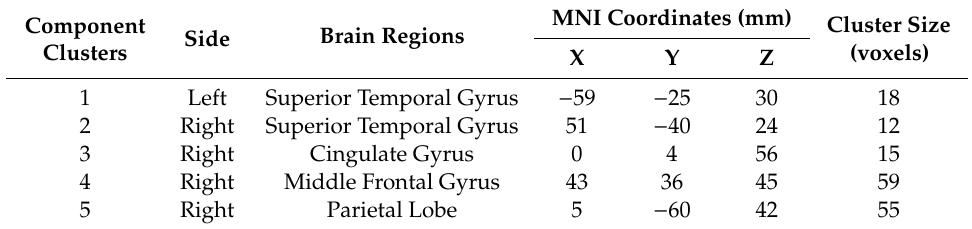
Table 1. Five dipole clusters in human brain, and the Montreal Neurological Institute (MNI) coordinates of their source distributions during visual and auditory stimuli, under human response